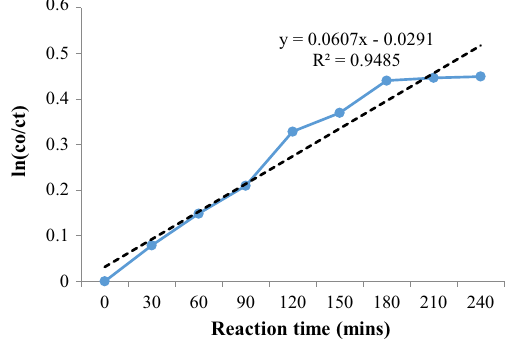
Fig. 7 kinetics of C.O.D removal in Fenton after coagulation